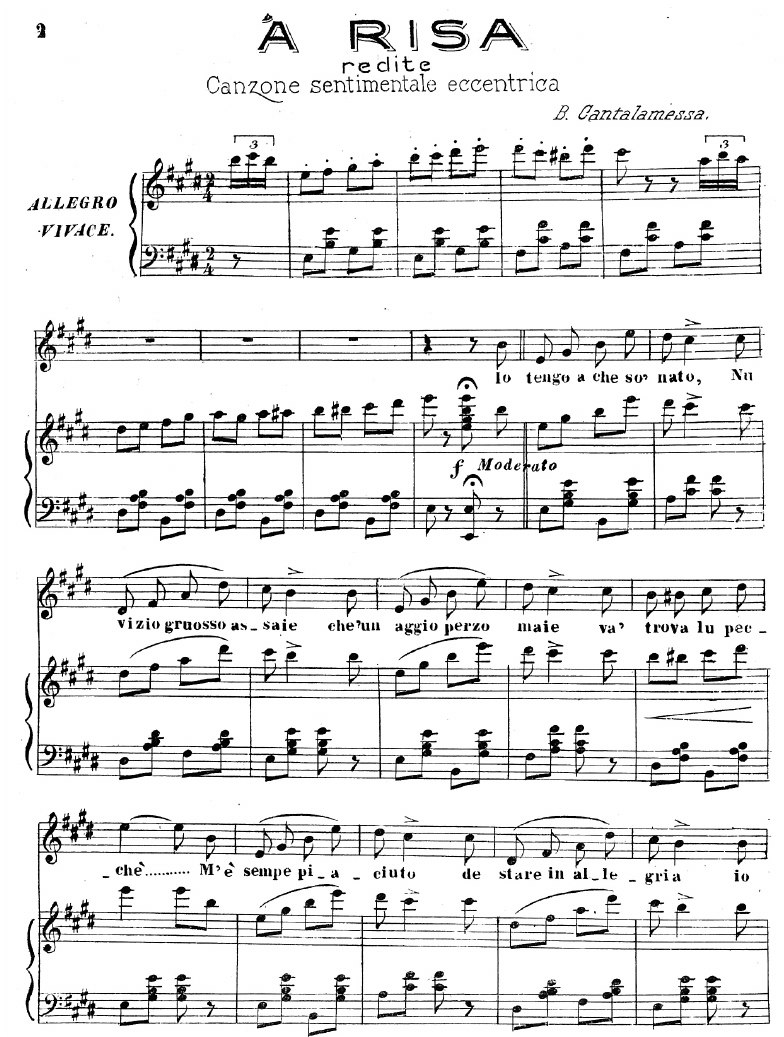
Fig. 3 Cantalamessa, “’A risa”, cover of sheet music and first